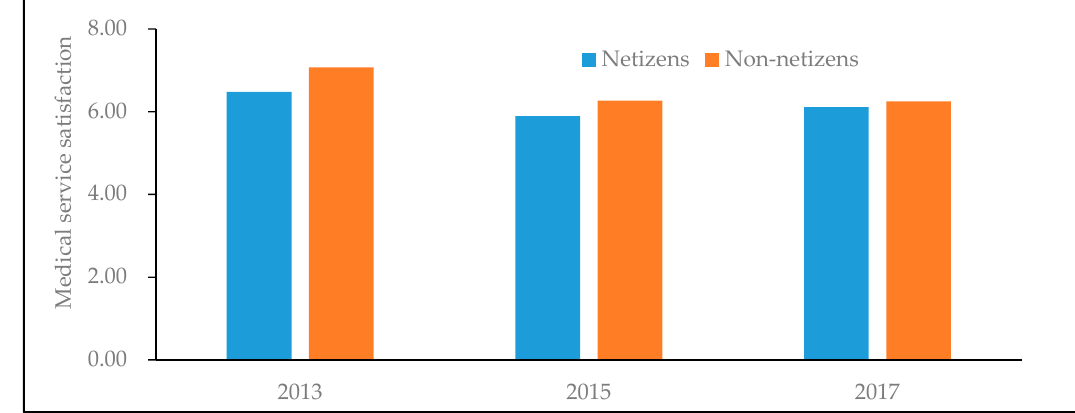
Figure 3. Differences in medical service satisfaction between netizens and non-netizens in different Figure 3. Di ff erences in medical service satisfaction between netizens and non-netizens in di ff erent years. Data are from the Chinese Social Survey [51] for 2013, 2015 and 2017. years. Data are from the Chinese Social Survey [51] for 2013, 2015 and 2017. Table 3. Internet use and medical service satisfaction (ordered probit).